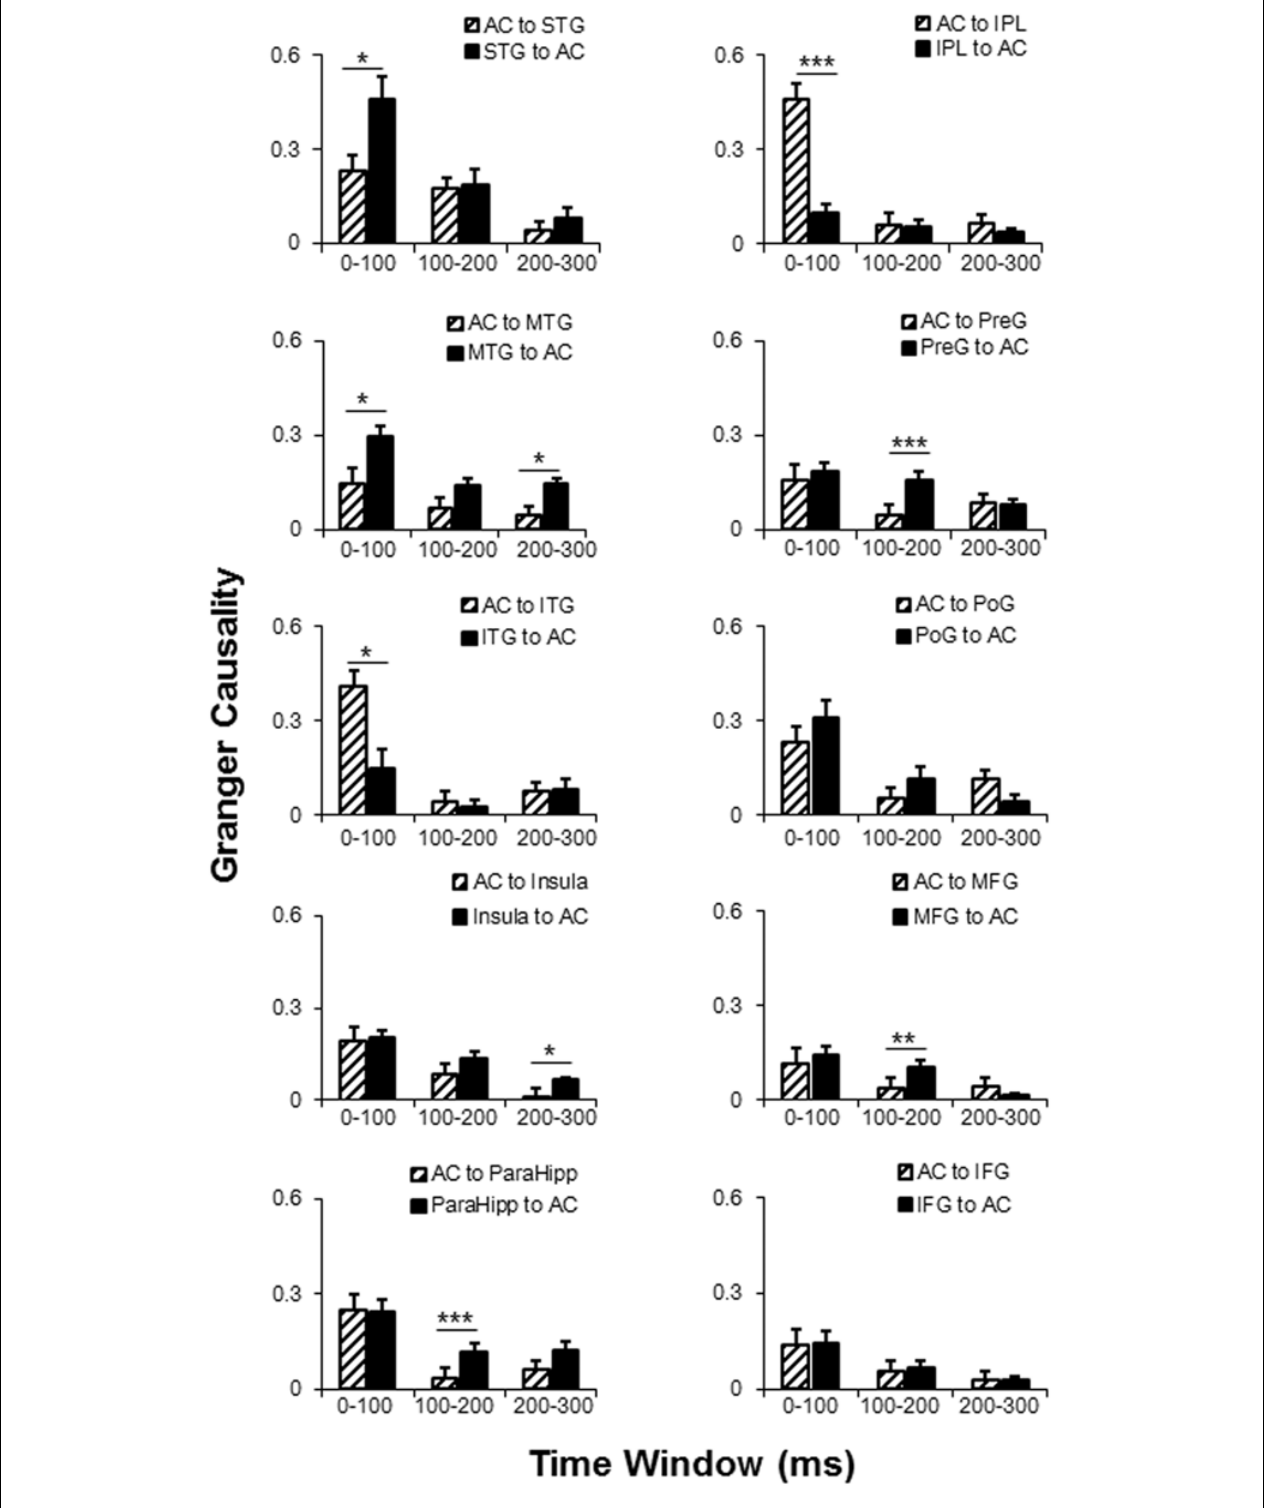
FIGURE 6 | Comparisons of the dynamic GC analyses between AC and the 10 non-auditory cortical areas. AC , auditory cortex; PreG , precentral gyrus; STG, superior temporal gyrus; poG, postcentral gyrus; IPL, inferior parietal lobule; IFG, inferior frontal gyrus; MFG, middle frontal gyrus; MTG, middle temporal gyrus; ParaHipo, para-hippocampus; ITG, inferior temporal gyrus. ∗ p < 0.05; ∗∗ p < 0.01; ∗∗∗ p < 0.001.